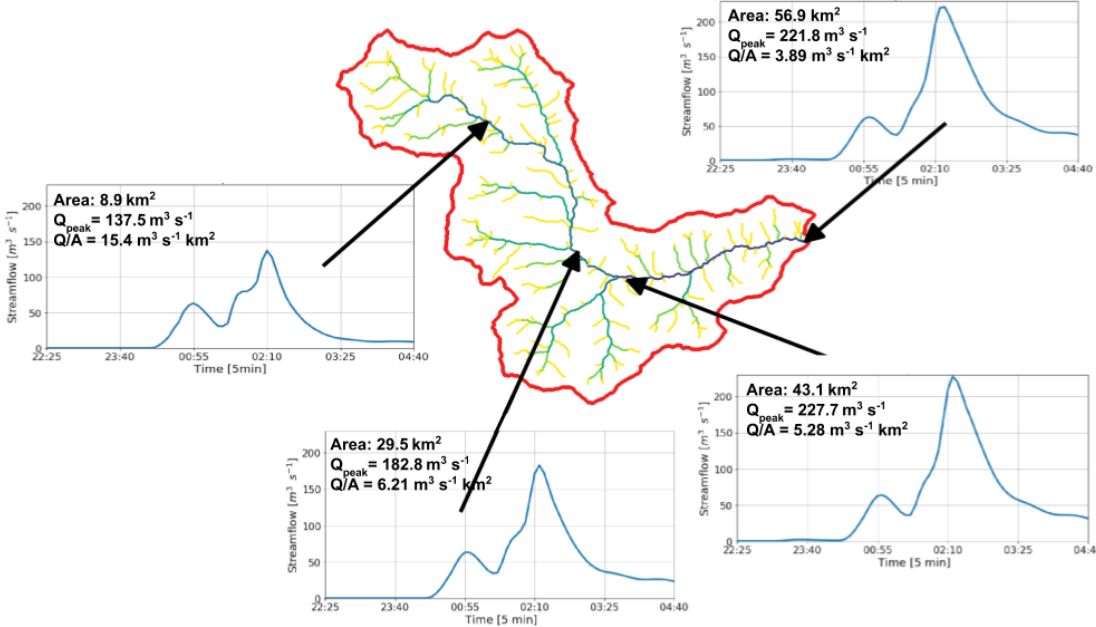
Figure 12. Temporal evolution of discharge during Event 2 in different locations along the watershed’s main channel. The upper location corresponds to 15% of the area of the basin, and the other downstream locations correspond to 52%, 76%, and 100% of the watershed,